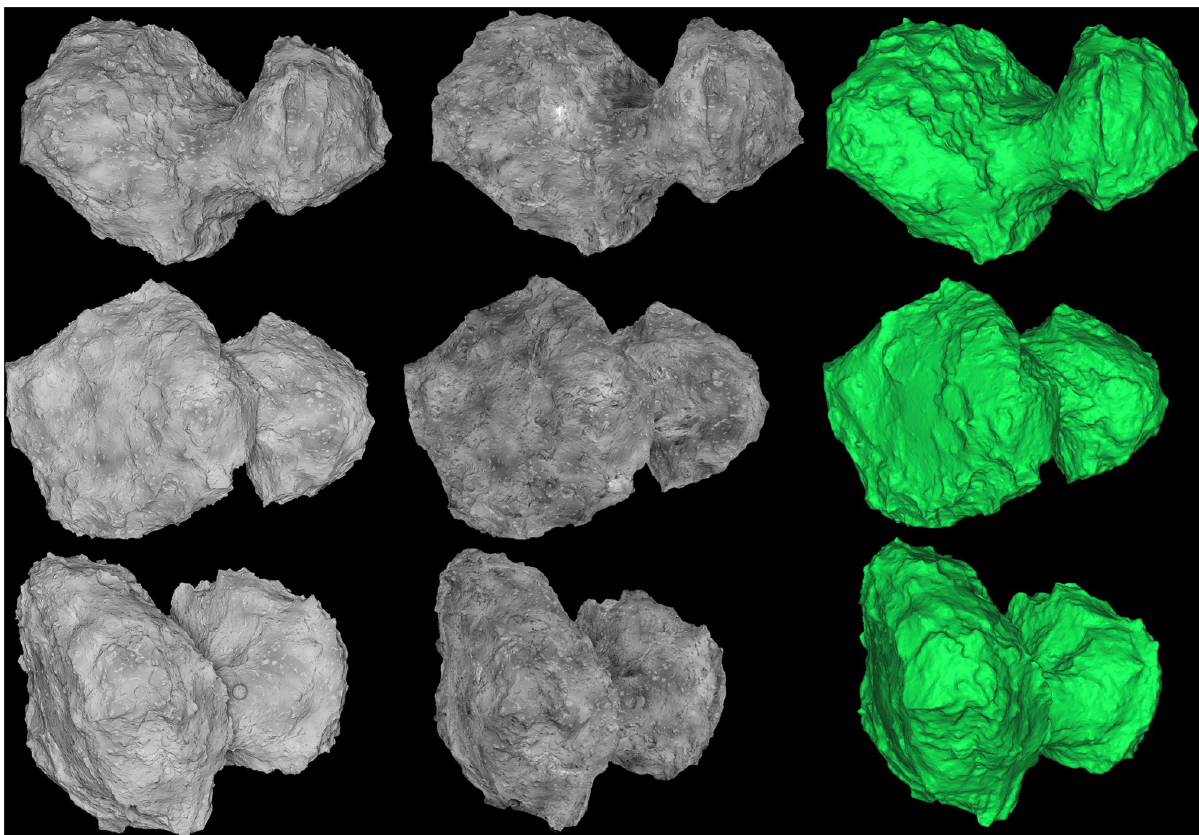
Fig 16. Full reconstruction of the comet during orbiting. The first column shows actual synthetic images, the second column is the textured view of the 3-D reconstruction, and the third column shows the meshed view of the reconstruction.